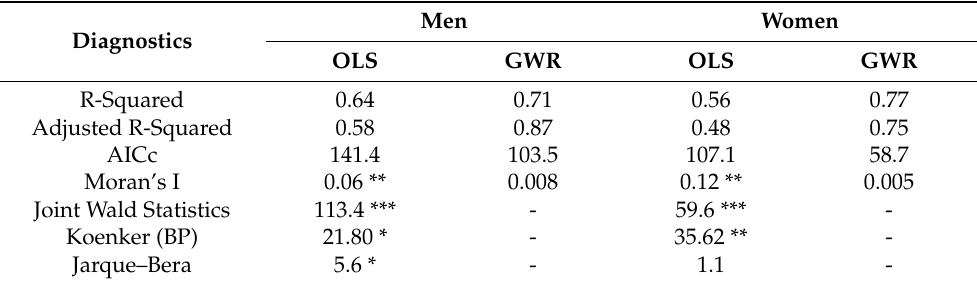
Table 3. Diagnostics of the modeling for men’s and women’s absence rate from work due to own illness or disability.